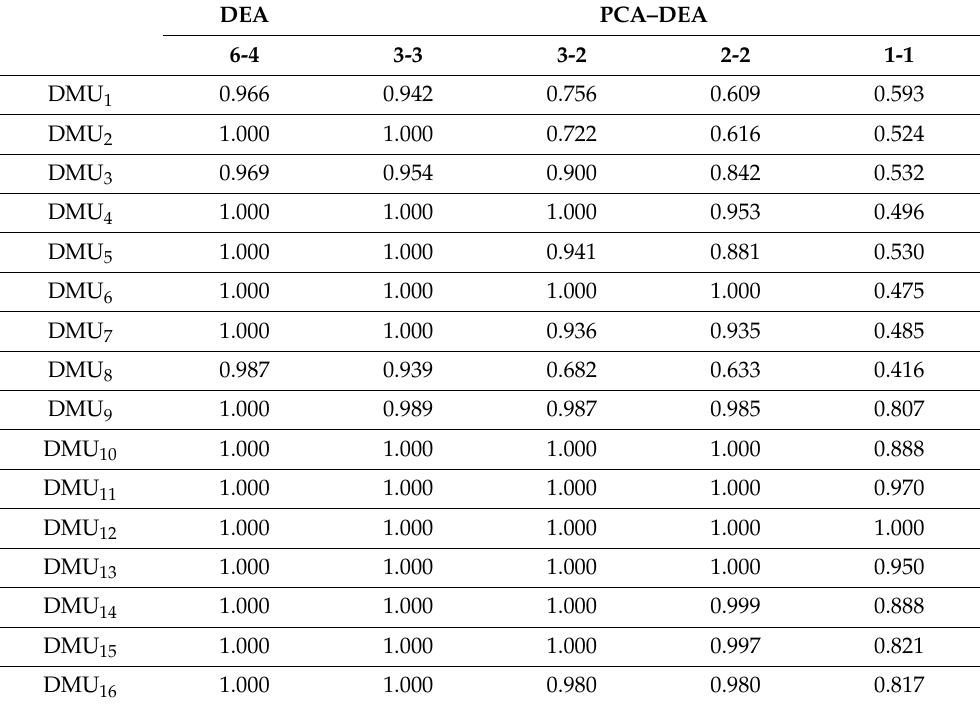
Table 4. Results of PCA–DEA models for both companies depending on the number of